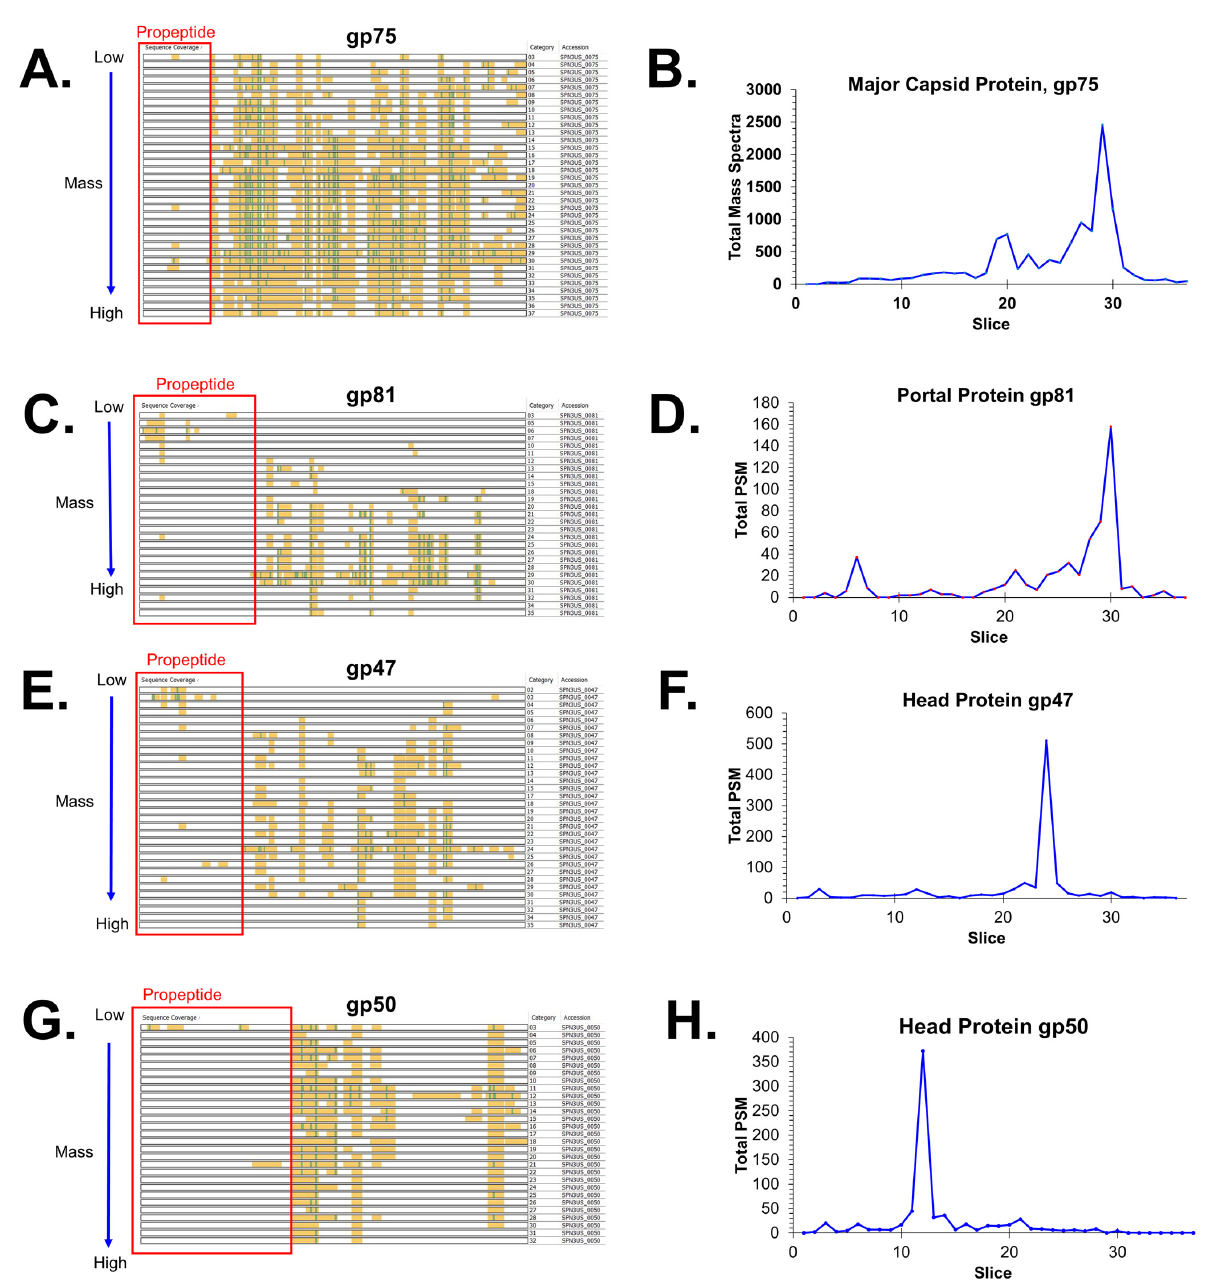
Figure 4. Mass spectrometry identification of SPN3US head proteins that are cleaved by the prohead protease (gp245) in 255 (am107). ( A , C , E , G ) Sequence coverage maps for the indicated proteins in the 37-slice 1-D SDS-PAGE separation of head particle proteins (Figure 2) ( A ) major capsid protein, ( C ) portal protein, ( E ) gp47, and ( G ) gp50. Plot of the total peptide spectrum matches (PSMs) assigned per gel slice for: ( B ) major capsid protein, ( D ) portal protein, ( F ) gp47 and ( H ) gp50.